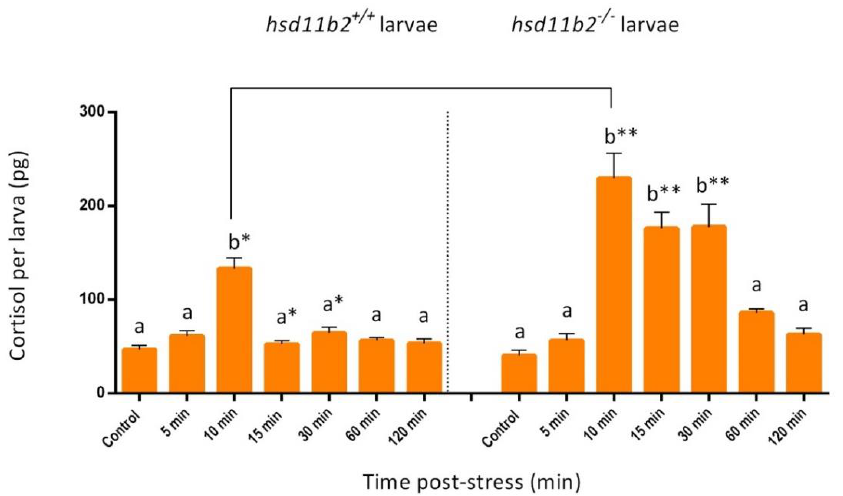
Figure 4. Effect of acute stress application on whole-body cortisol concentrations of individual lar-